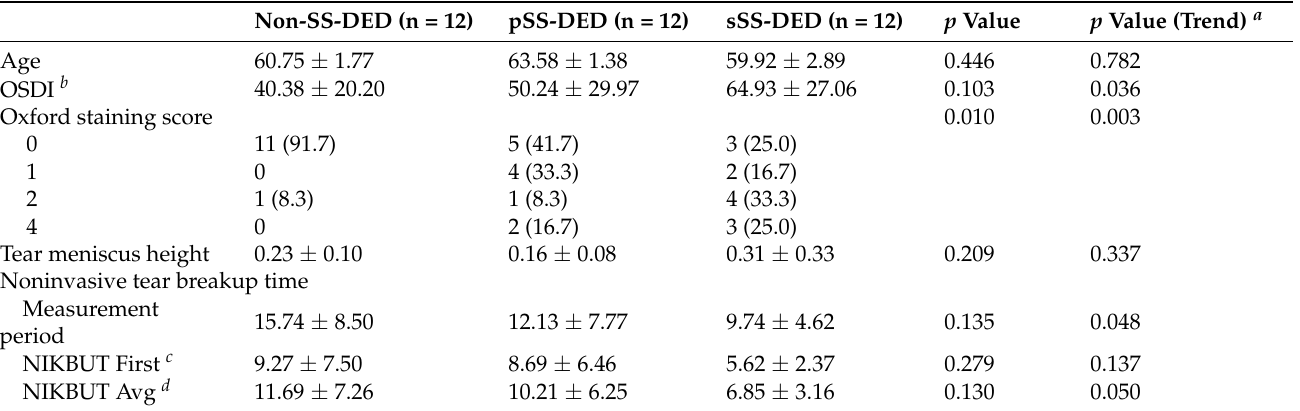
Table 1. Demographic